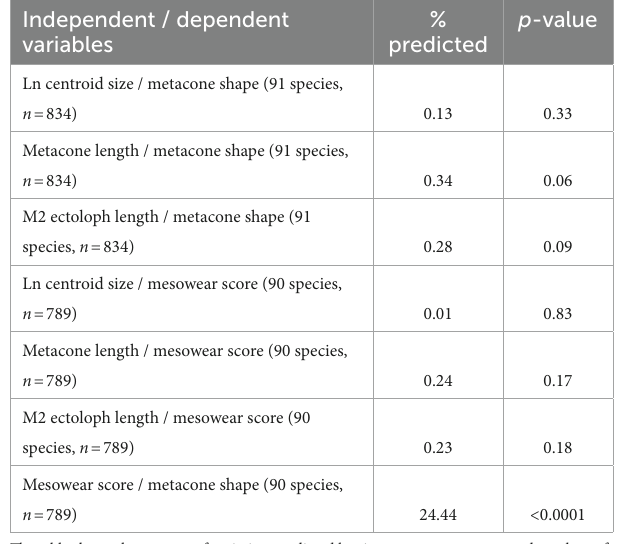
TABLE 3 Results of regression